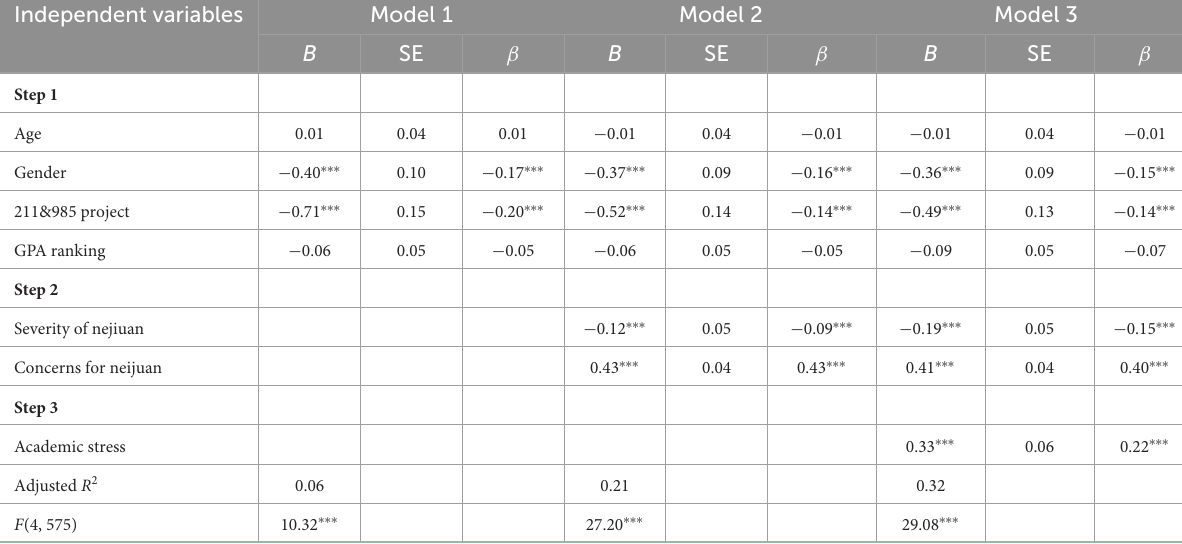
TABLE 5 Hierarchical regression analysis on coping motives.